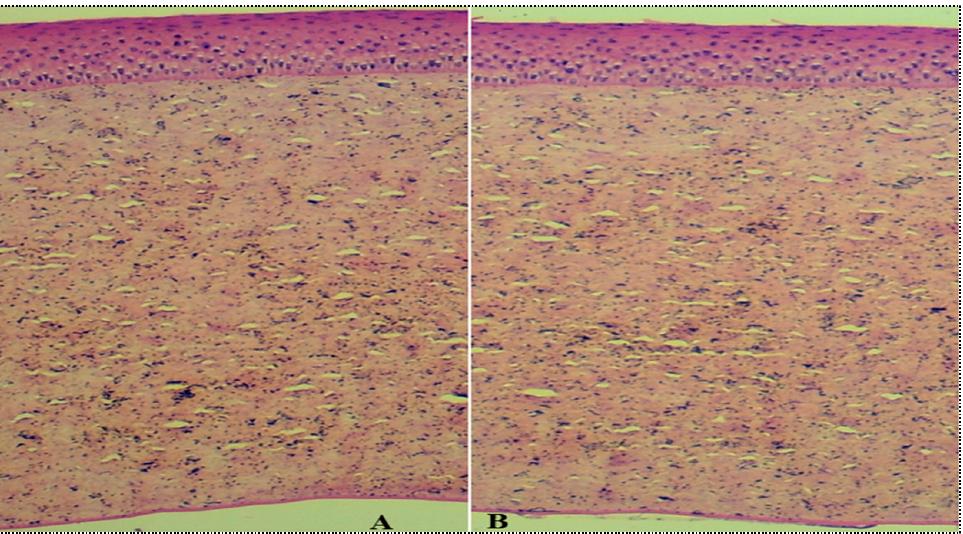
Figure 9. Histopathology images of ( A ) moxifloxacin-loaded bilosome in situ gel (MX-BSop-Ig4) and ( B ) normal-saline-treated cornea.